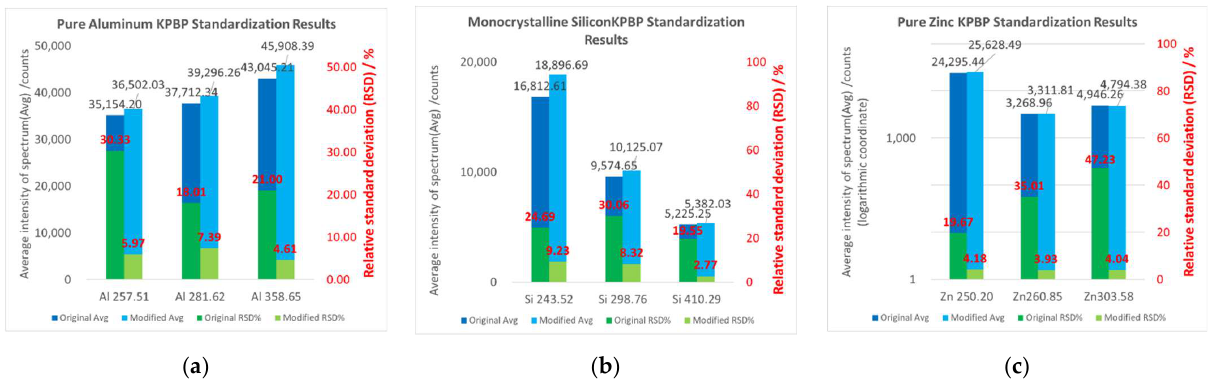
Figure 7. The KPBP standardization results for ( a ) pure aluminium, ( b ) monocrystalline silicon, and ( c ) pure zinc.